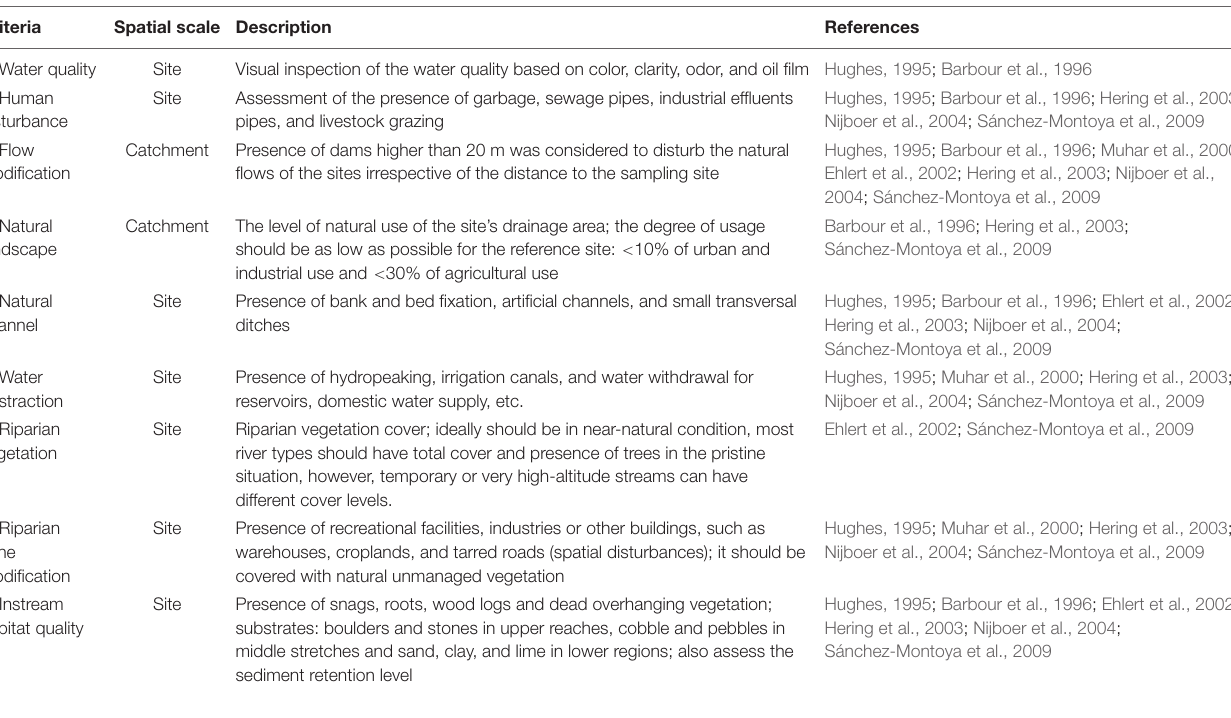
TABLE 5 | Selection criteria for minimally disturbed KwaZulu-Natal river sites (adapted from Chaves et al., 2006). Criteria Spatial scale